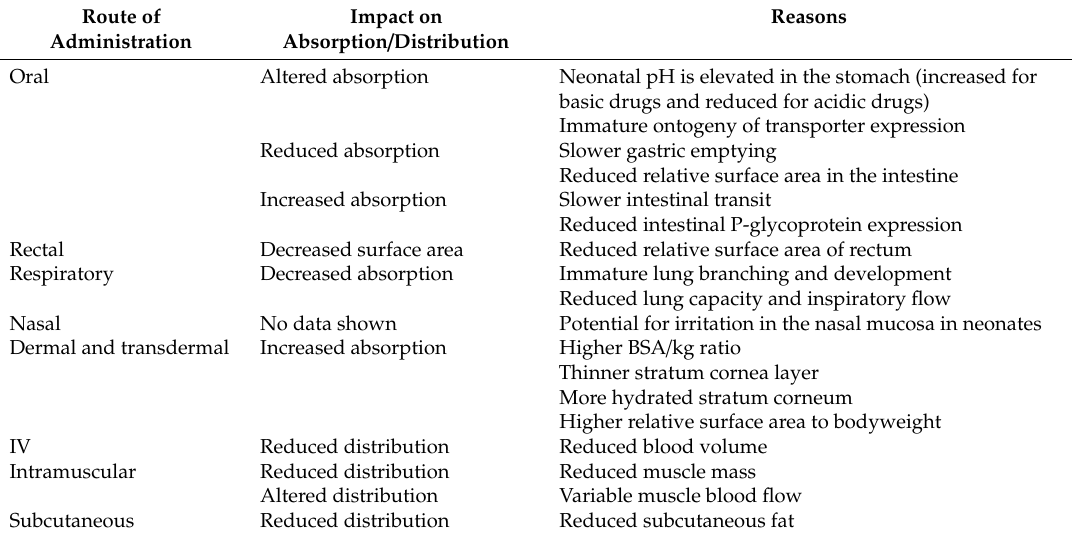
Table 4. Summary of di ff erences between neonatal and adult physiology that a ff ect absorption / distribution of drugs (extracted from